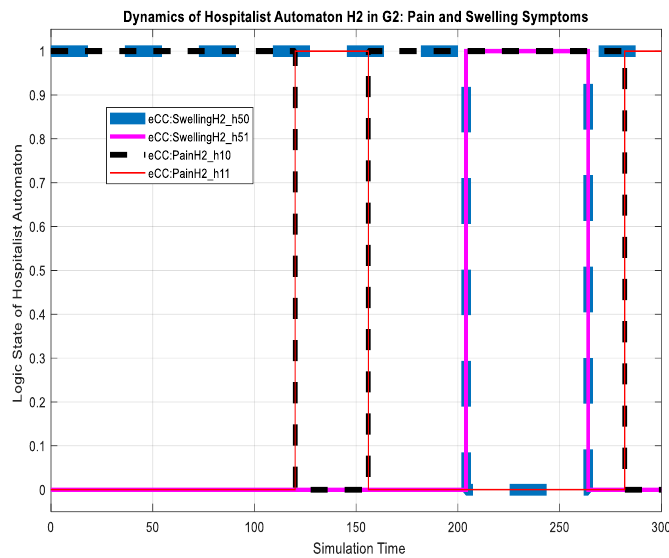
Figure 27. Dynamics of patient automaton H 2 in G 2 in terms of monitoring the pain and swelling symptoms.